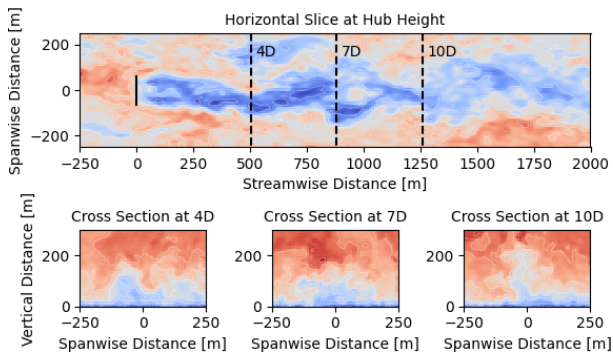
Figure A1. Examples of SOWFA data used to generate inflow for FAST